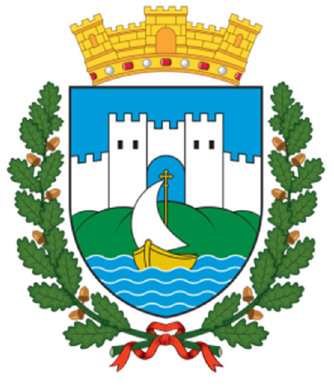
Figure 19. Coat of arms of Ohrid.